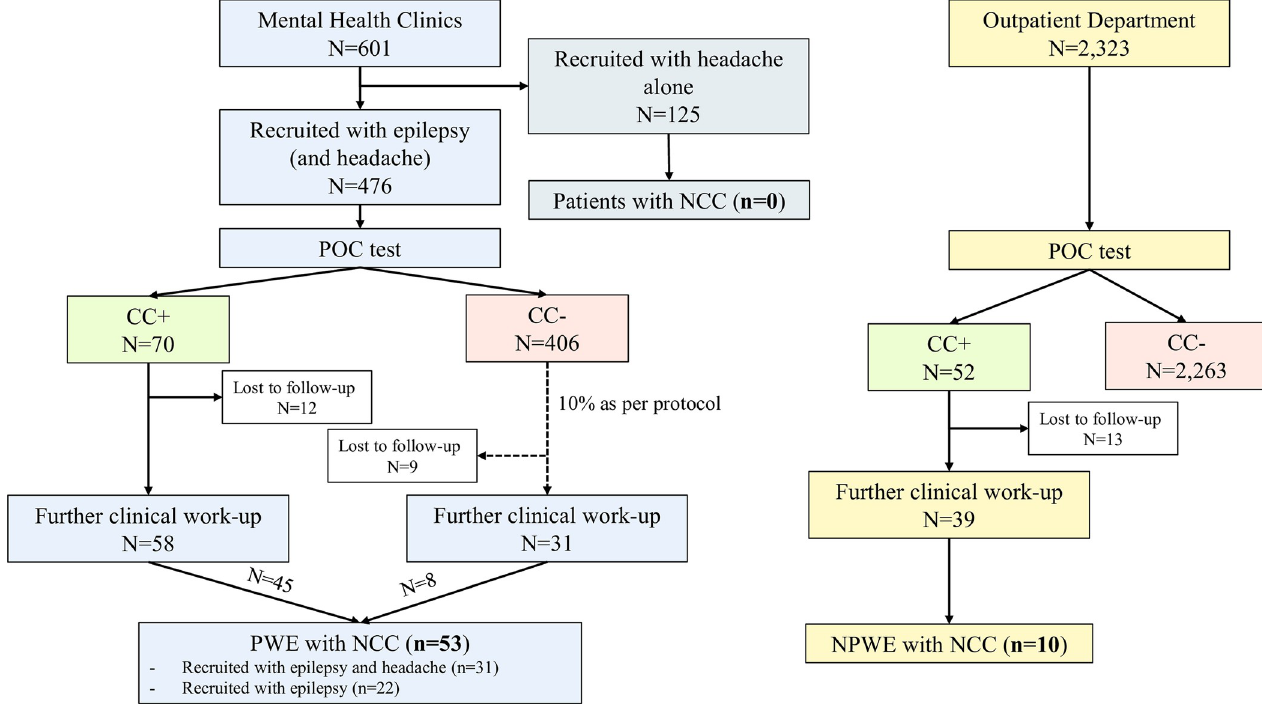
Fig 1. Flowchart of the patients included in this analysis. POC test results include second POC testing. All patients who had their further clinical work-up performed more than 2 months after the first. POC test, were POC tested again on the day of the work-up. The latest POC result is presented here. PWE People with epileptic seizures. NPWE People without epileptic